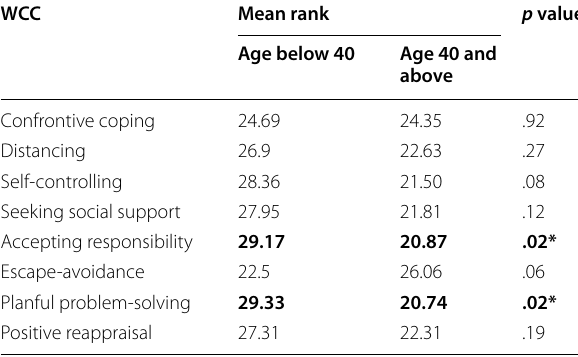
Table 5 Mann-Whitney U test for “age-groups” and “ways of coping in patients of schizophrenia with asymptomatic